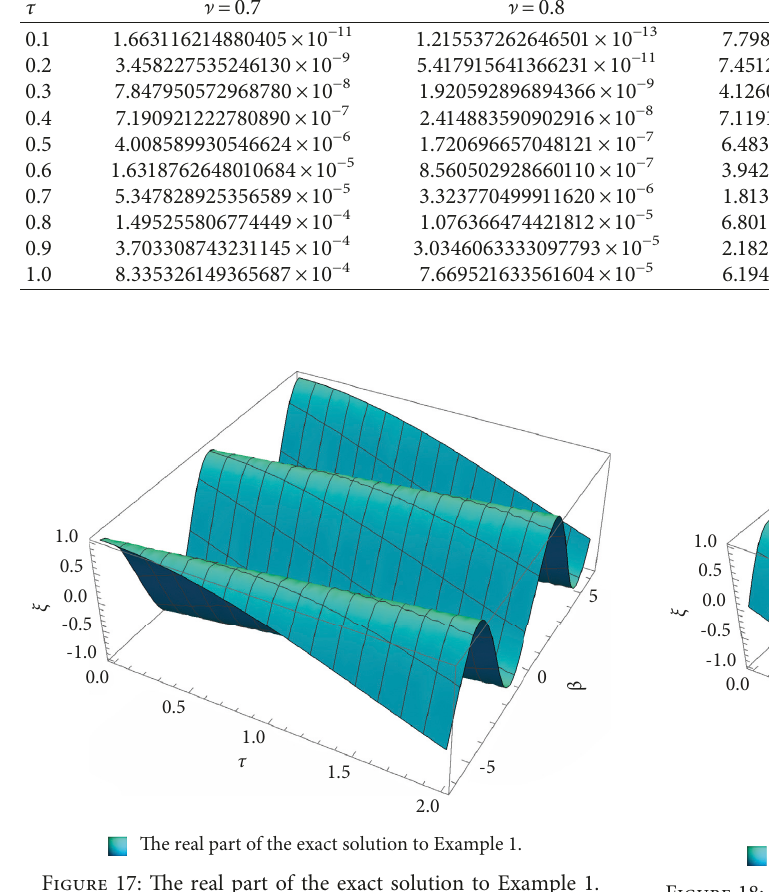
18: The imaginary part of the exact solution to Example